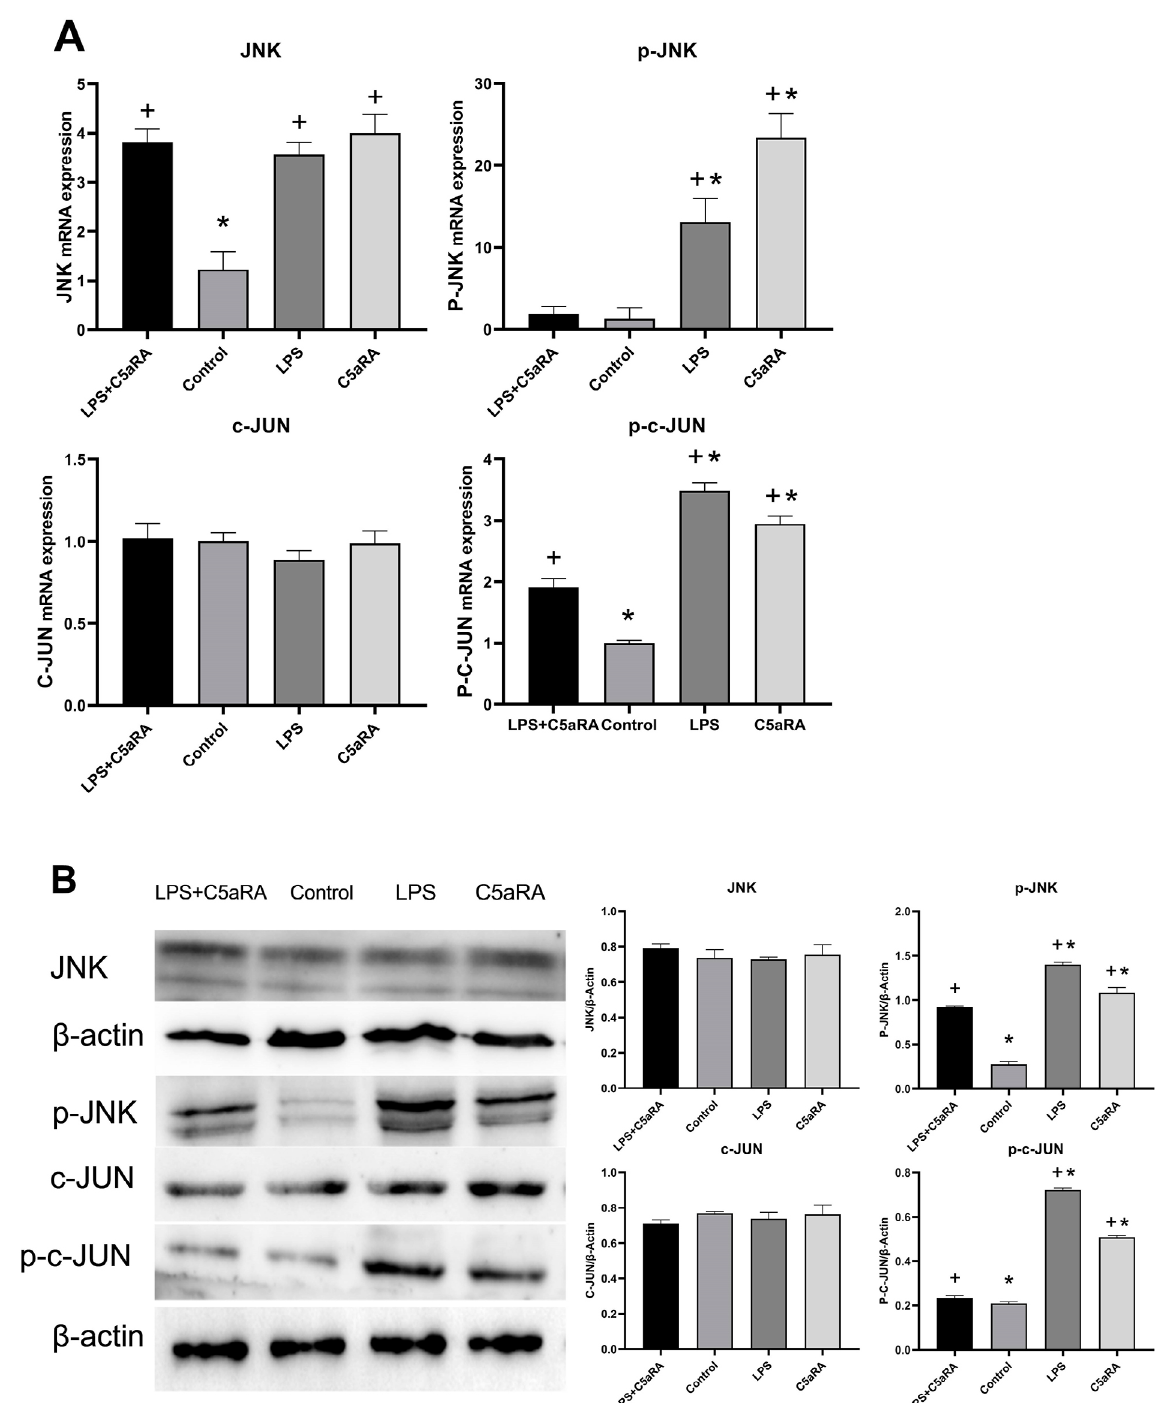
Figure 8- Effects of C5aRA on MAPK signal pathway activation in LPS-stimulated HGFs.(A) Effects of C5aRA on mRNA levels of JNK, p-JNK, c-JUN, and p-c-JUN in LPS-stimulated HGFs. (B) Effects of C5aRA on protein levels of JNK, p-JNK, c-JUN, and p-c-JUN in LPS- stimulated HGFs. Data represent the mean ± SEM. of three independent experiments. +P<0.05 vs. the control group. *P<0.05 vs. the LPS+C5aRA